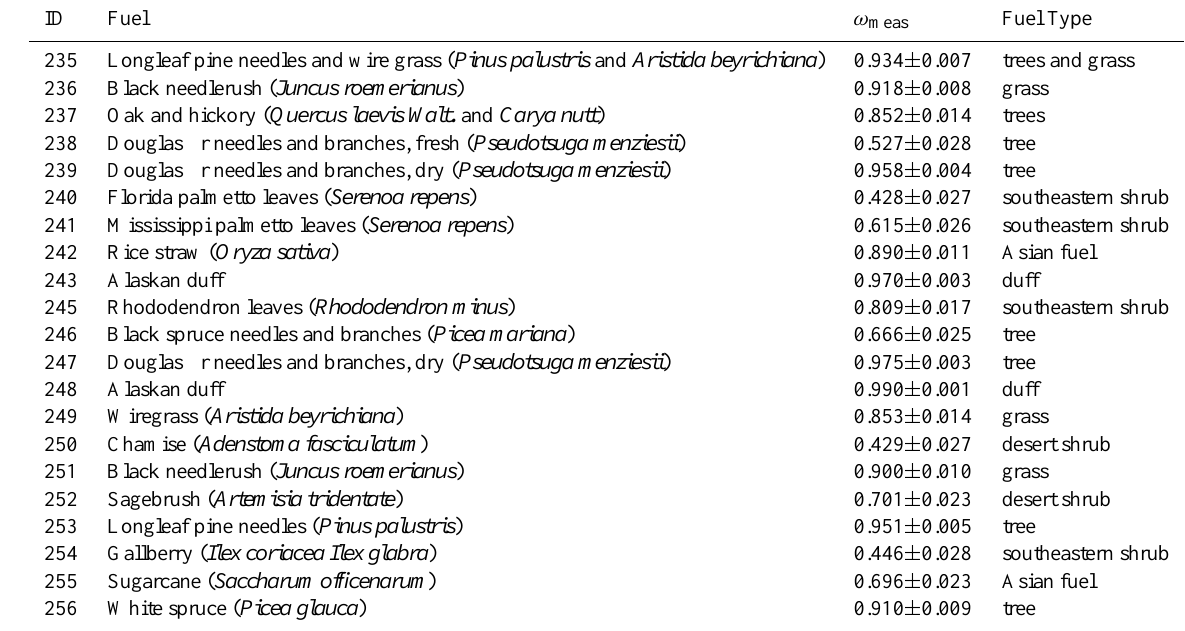
Table 1. List of burns analyzed in this work. ID: Burn ID as catalogued in McMeeking et al. (2009). ω meas : single-scattering albedo at λ = 532nm determined from nephelometer and photoacoustic spectrometer measurements, shown with associated relative uncertainty (Eq.